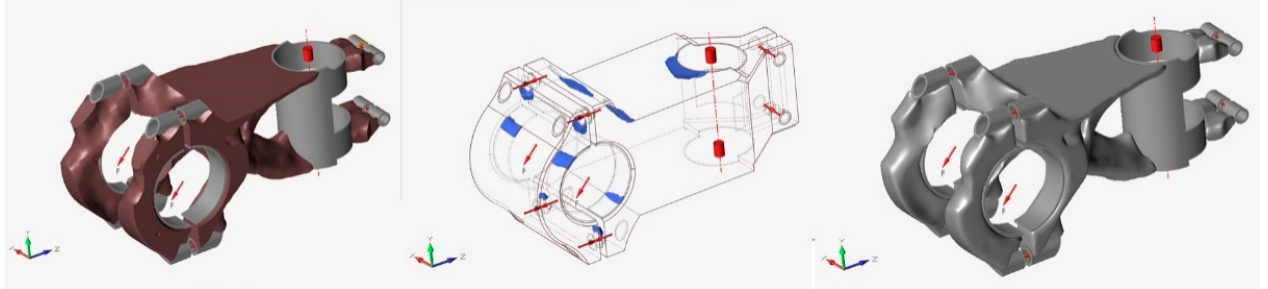
Figure 7. Result of the topological optimization on the left, the middle image shows the highest stress concentration areas and, on the right, the smoothed surface using NURBS, carried out with Inspire software.